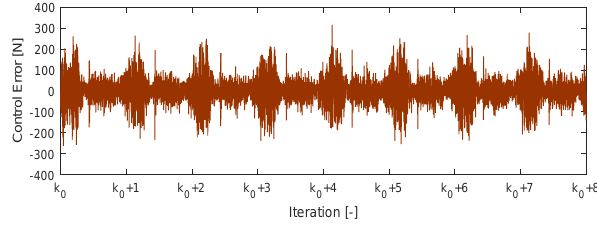
Figure 21: Control error after convergence of the ILC.